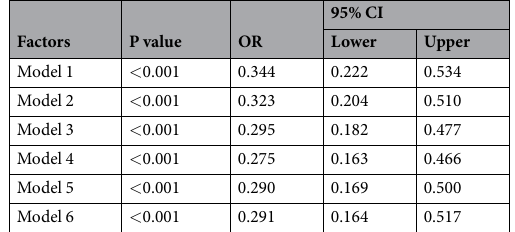
Table 3. Logistic Regression of the Relationship between 10 * (F-V Ratio) and Hemorrhagic MMD or MMS. Model 1: univariate analysis of 10 * (F-V Ratio). Model 2: adjusted by age and gender on the basis of Model 1. Model 3: adjusted by Suzuki stage (Suzuki 3–4) on the basis of Model 2. Model 4: adjusted by the dilation of AchA (grade 2) on the basis of Model 3. Model 5: adjusted by the dilation of Pcom (grade 2) on the basis of Model 4. Model 6: adjusted by complicated aneurysm on the basis of Model 5.